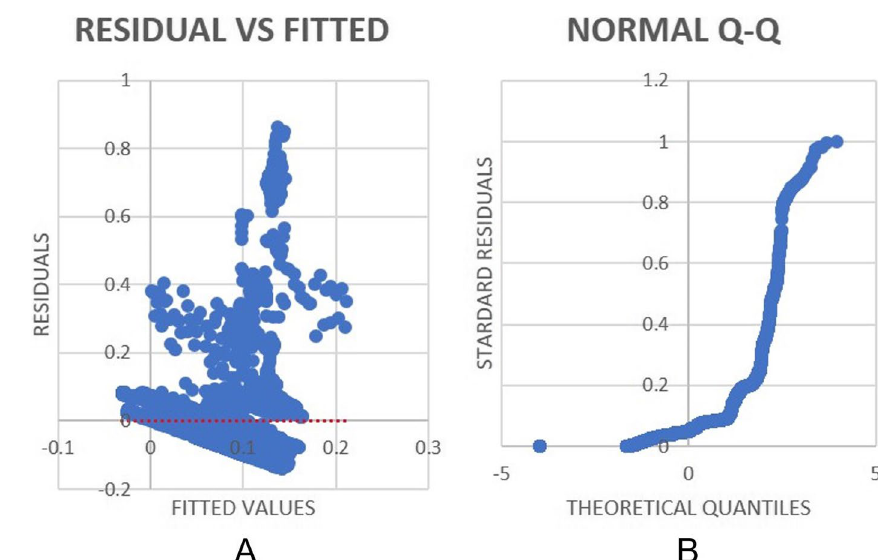
Fig. 9 EDA Regression: Residuals VS Fitted values curve ( A ) and Q-Q Plot ( B